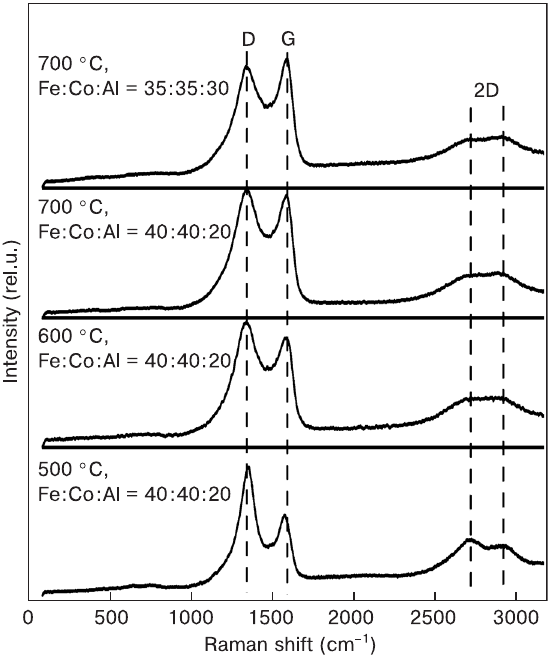
Figure 3. Raman spectra of FeCoAl/C nanocomposites synthe - sized at different temperatures and metal ratios.